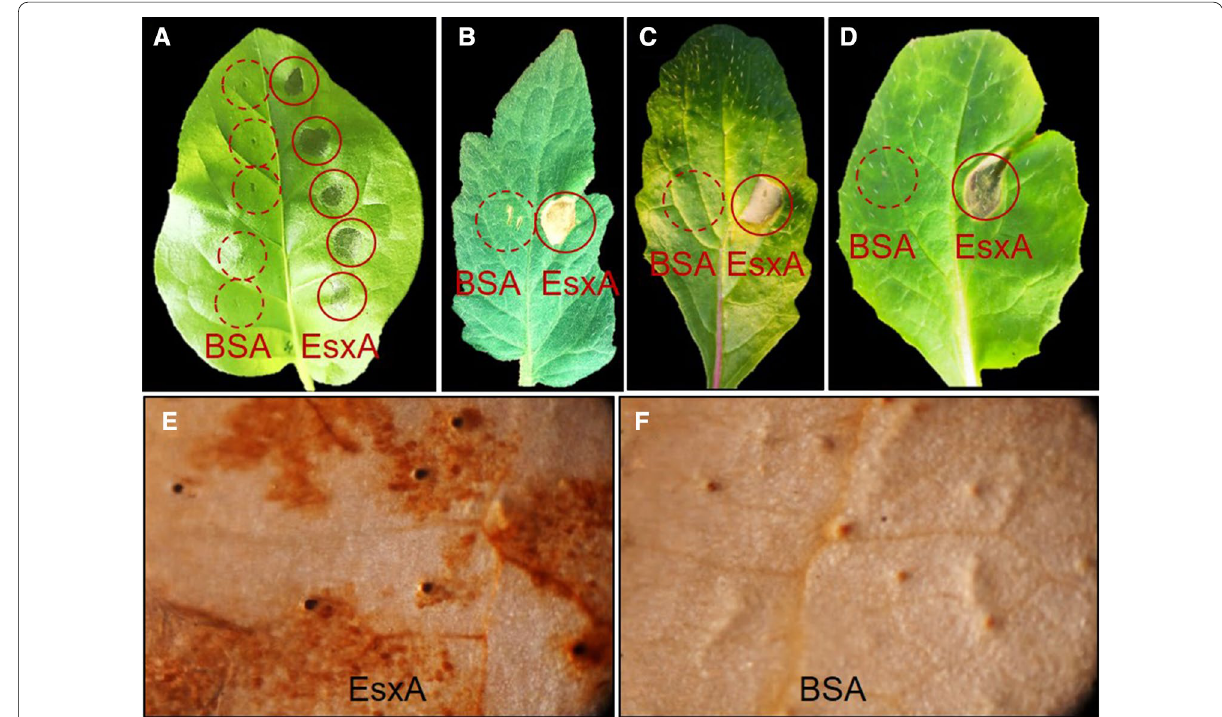
Fig. 5 Hypersensitive reaction in various plants and reactive oxygen species burst in tobacco leaves treated with EsxA. A – D hypersensitive response in leaves of Nicotiana tabacum , Solanum lycopersicum , Scrophularia ningpoensis , and Brassica rapa L. ssp. chinensis injected with EsxA, respectively. Con represents control (BSA), EsxA represents EsxA injected; E , F Detection of reactive oxygen species in the tobacco leaves growing above those injected with EsxA and in control leaves injected with bovine serum albumin, respectively